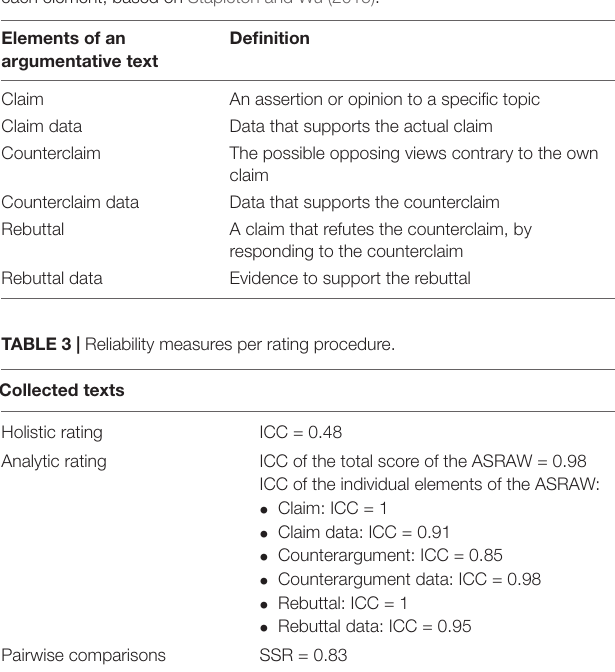
TABLE 2 | Overview of the elements of an argumentative text with a definition of each element, based on Stapleton and Wu (2015).